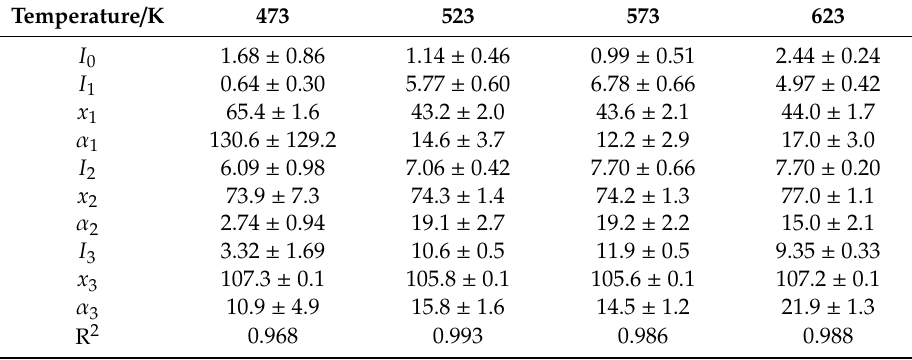
Figure 13. As in Figure 12, but at 623 K surface temperature. Table 1. CO 2 angular desorption parameters from fitting of profiles in steady-state CO oxidation from Pt{110}-(1 × 2) at four surface temperatures. Angles x 1 – x 3 are highlighted and R 2 , the coefficient of determination, for each fit is given. Data at 523 and 573 K are shown in Figure S5a,b. Temperature/K